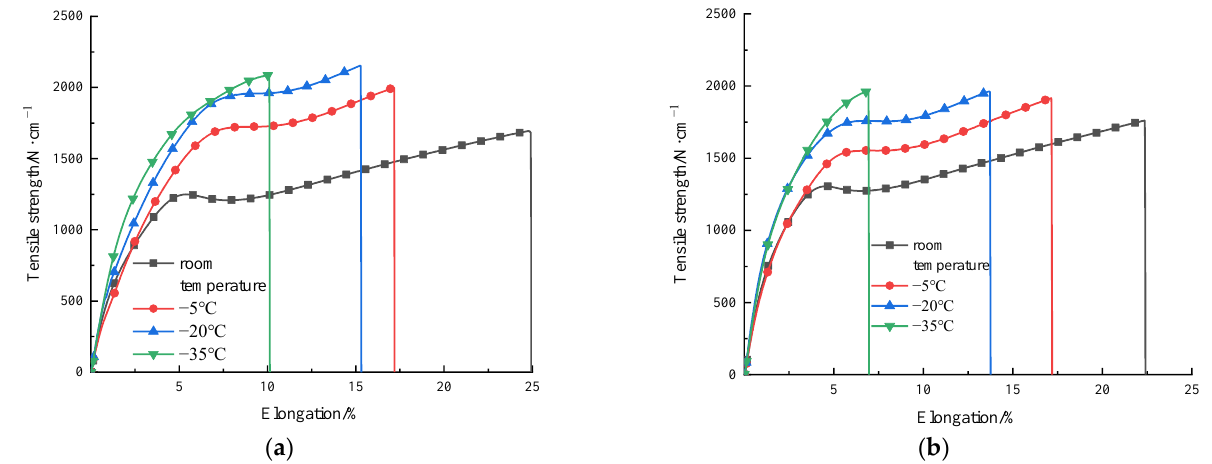
Figure 12. Tension curves of PET specimens I ( a ) and II ( b ) respectively at different temperatures.